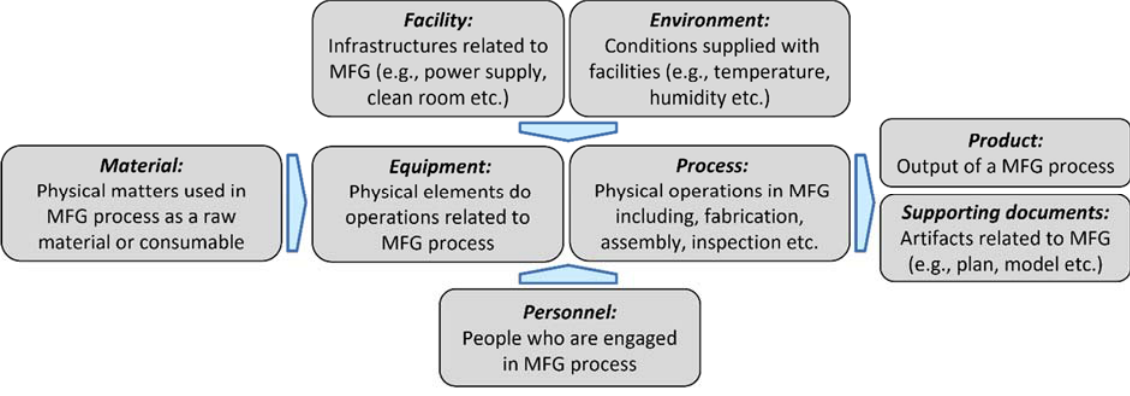
Figure 2. Observable Manufacturing Elements (OMEs) [6] . MFG = manufacturing.